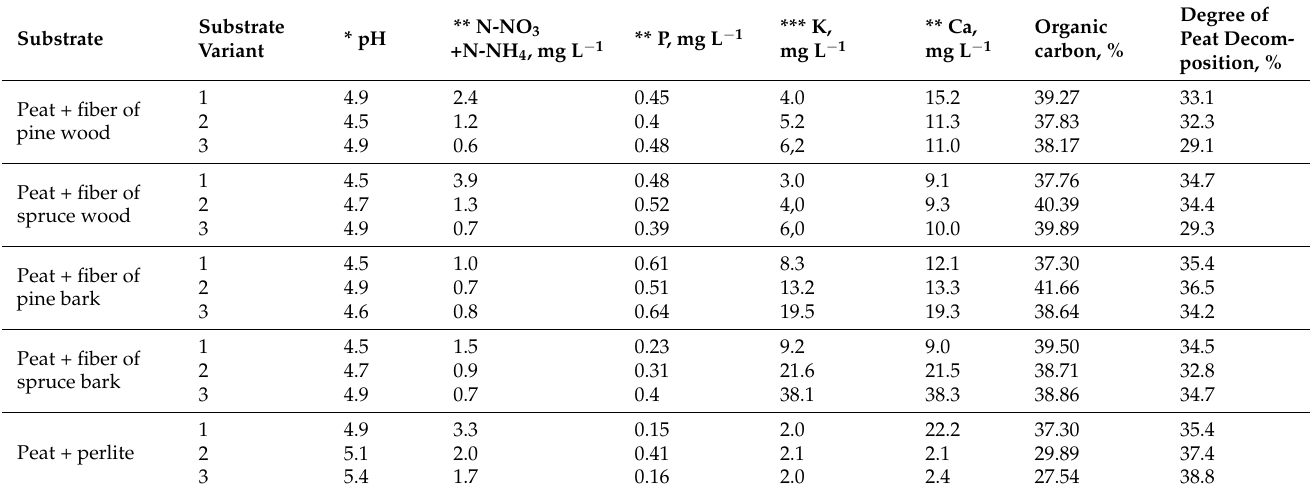
Table 2. Chemical composition of the